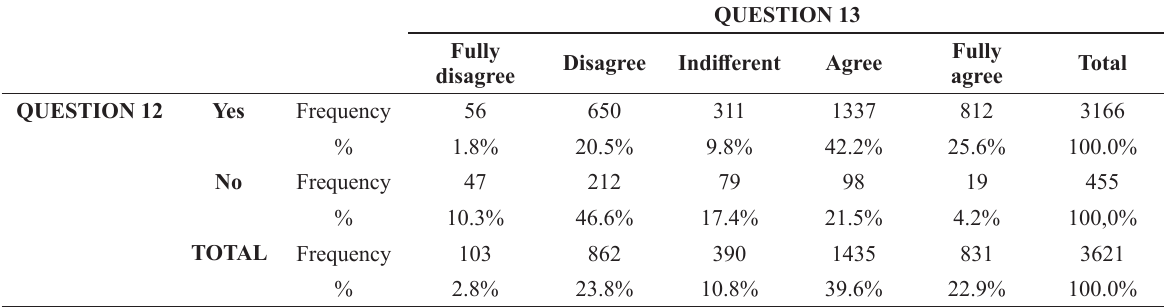
Pearson’s Chi-squared Test for Questions 12 versus Question